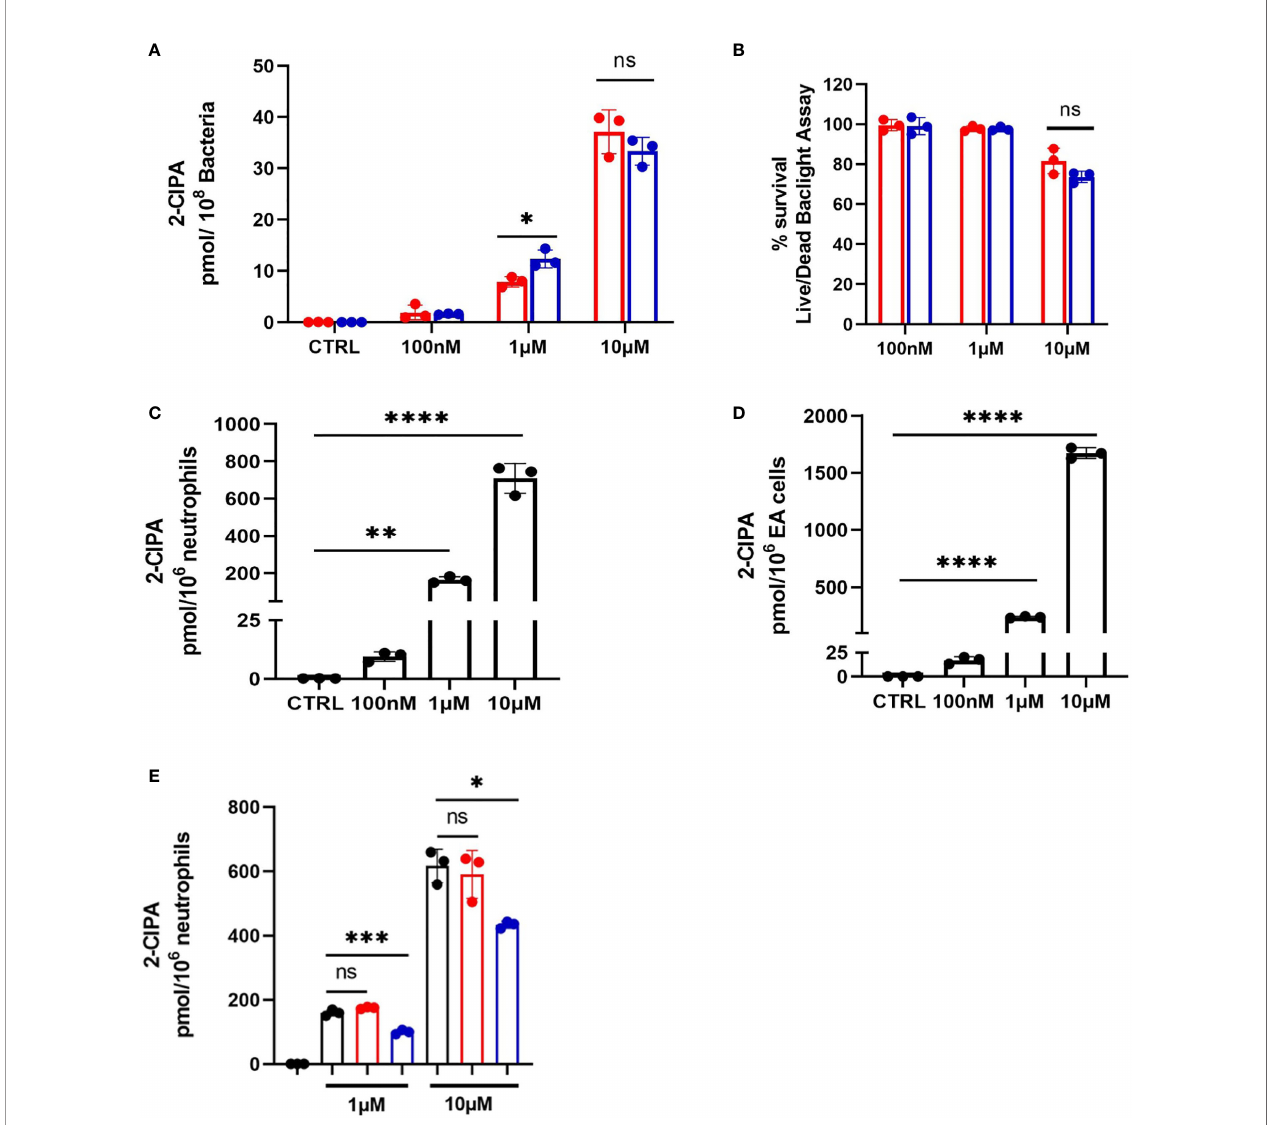
FIGURE 6 | 2-ClFALD metabolism in host cells and bacteria. (A) Indicated concentrations of the 2-ClFALD molecular species, 2-chlorohexadecanal, in 0.1% EtOH in HBSS media were exogenously provided to 50 x10 6 /ml CFT073 (red) and JM109 (blue) cells for 1h at 37°C. Metabolized free 2-chloropalmitic acid (2-ClPA) was measured as described in “ Material and Methods ” . (B) Following indicated 2-chlorohexadecanal treatments for 1h, CFT073 and JM109 viability was measured using Live/Dead Baclight Bacterial viability kit as described in “ Material and Methods ” . Percent survival was calculated relative to the control bacteria. (C) Neutrophils (1x10 6 /ml) or (D) EA hy296 cells (EA) were incubated with indicated concentrations 2-chlorohexadecanal for 1h at 37°C to determine conversion to 2-ClPA. (E) Neutrophils were cocultured with either CFT073 (red) or JM109 (blue) with exogenously provided 2-chlorohexadecanal for 30 min and 2-ClPA was measured. Control neutrophils are in black. Statistics were done using unpaired t-test (A, B) and one-way ANOVA with Tukey ’ s multiple comparison test (C – E) . Error bars represents ± SD, n=3, p-value: ****< 0.0001; ***< 0.001; **< 0.01; * < 0.05. ns indicates not signi fi